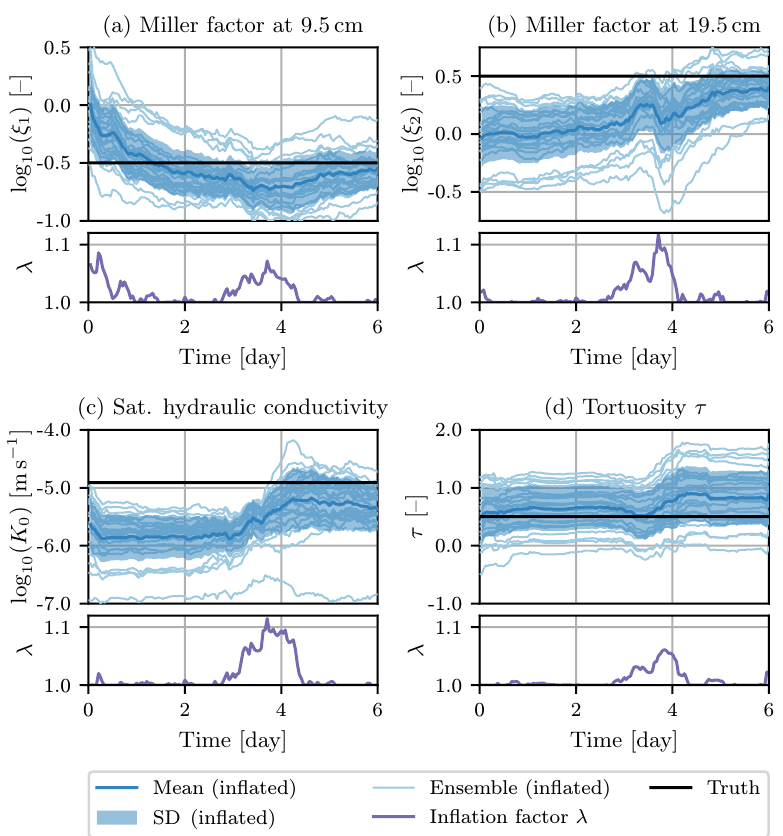
Figure 3. Development of Miller scaling factors ξ 1 and ξ 2 , saturated hydraulic conductivity K 0 , and tortuosity τ together with their corre- sponding inflation factors during estimation with the